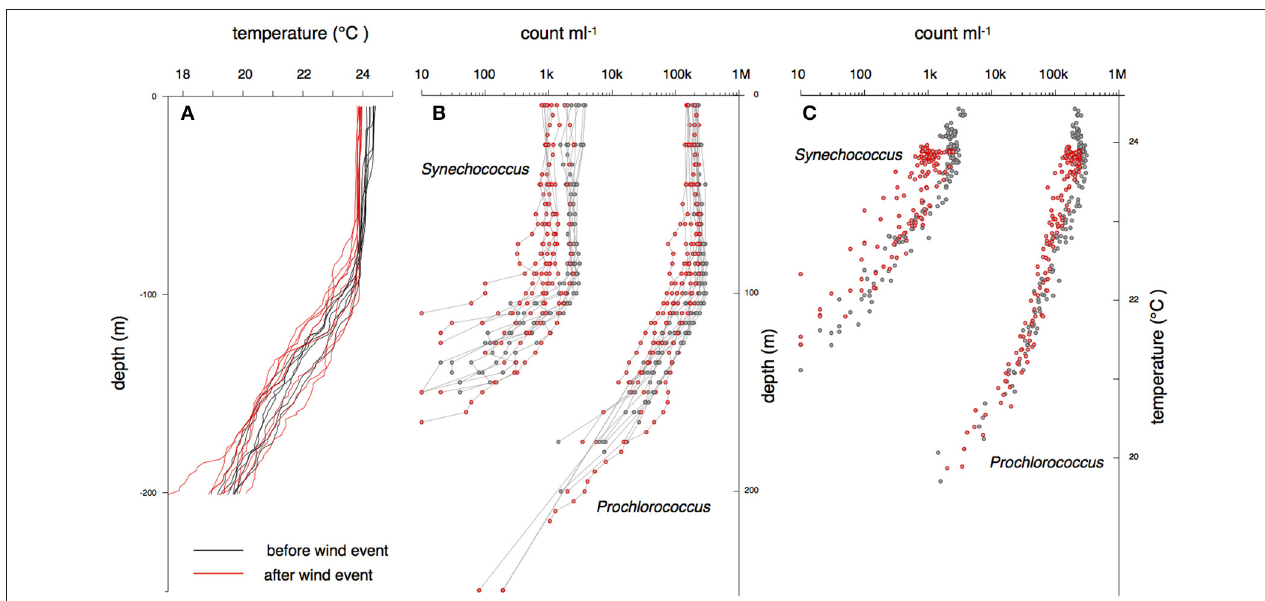
FIGURE 4 | Temperature and cell abundance profiles collected during the 2-week period at Station ALOHA in March 2014 shown in Figure 3 . Black lines indicate samples collected before a peak in wind-driven mixing and red lines indicate samples collected after the peak in wind-speed ( Figure 3 ).